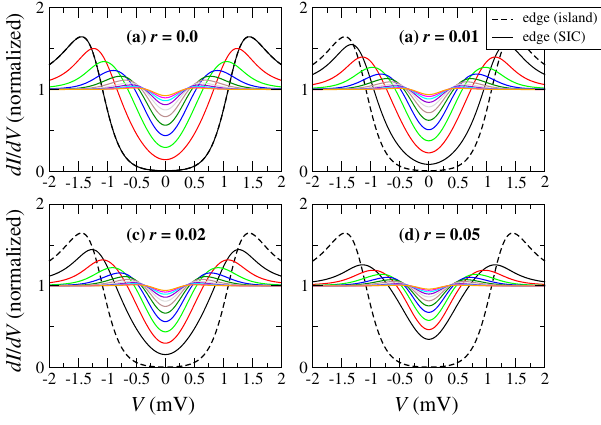
FIG. 10. The same as in Fig. 9, but for T ¼ 2 . 05 K.